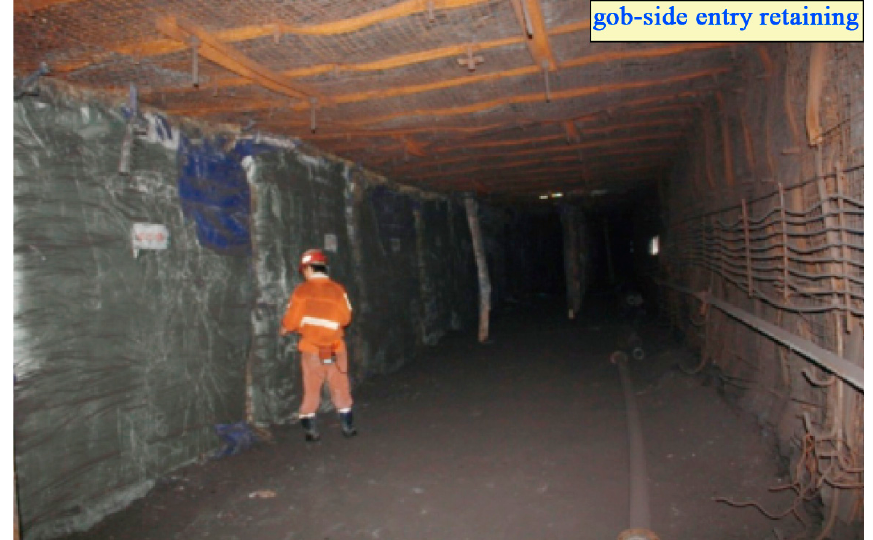
Figure 24. Deep displacement monitoring of gob-side entry-retaining technology.